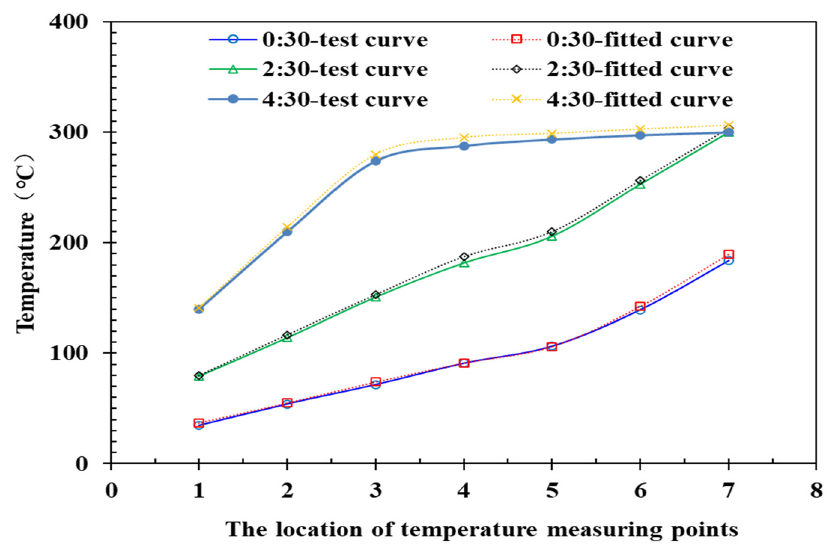
Figure 7. Temperature fitting results of water.